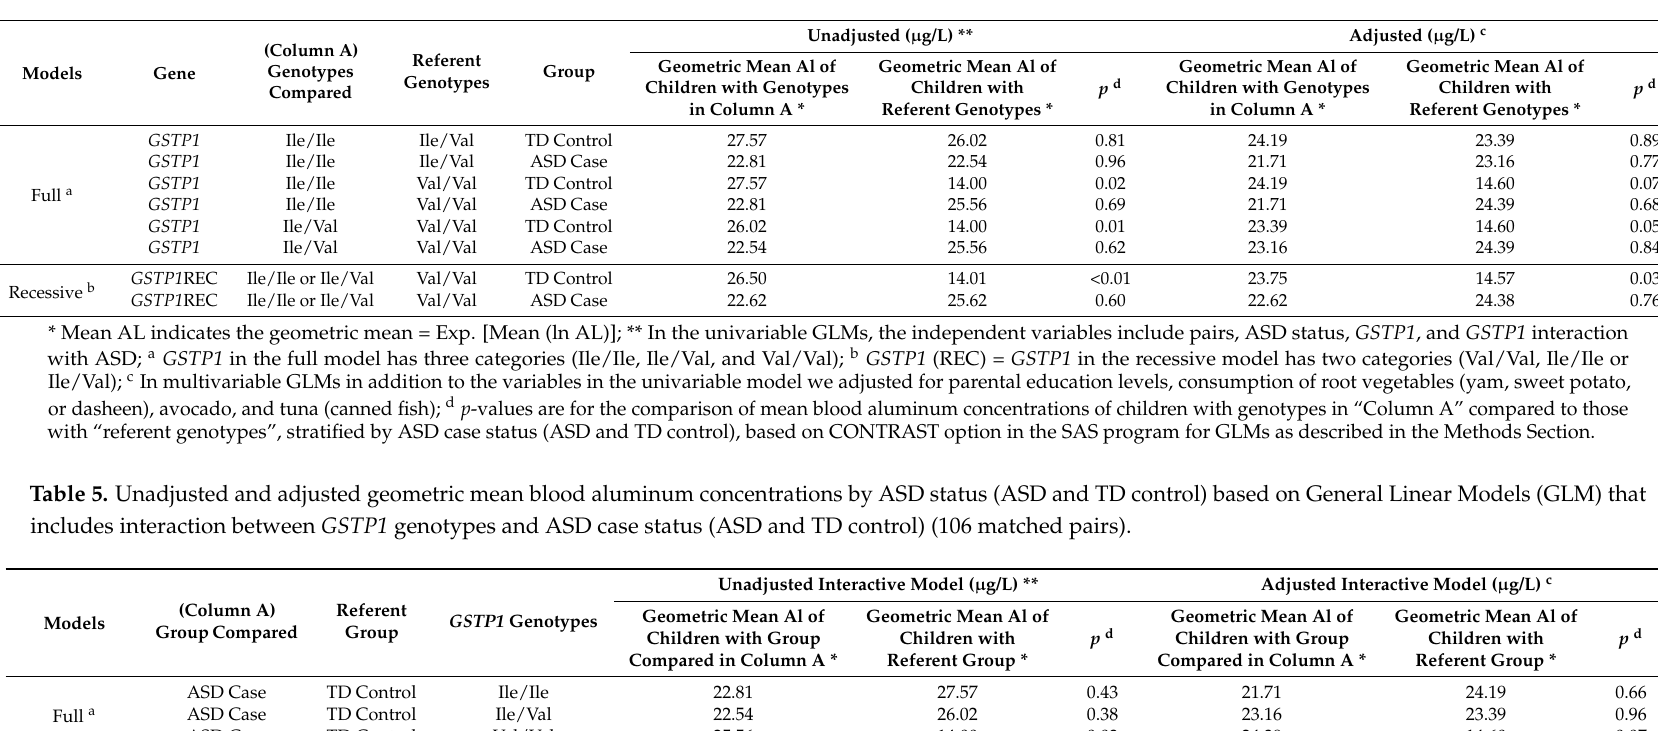
Table 4. Unadjusted and adjusted geometric mean blood aluminum concentrations by GSTP1 genotypes based on General Linear Models (GLM) that include interaction between GSTP1 and ASD case status (ASD and TD control) (106 matched pairs).